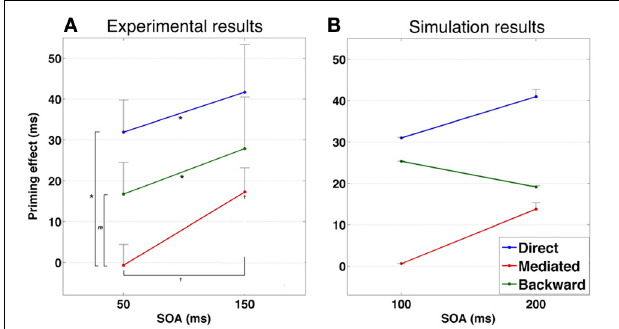
FIGURE 9 | (A) Priming results in Experiment 2. Error bars represent ± 1 standard error of the mean. † indicates significance level of 0.05 or better; ∗ indicates significance level of 0.01 or better. m indicates a marginally significant result ( p < 0 . 08). (B) Simulated priming results corresponding to Experiment 2 under similar